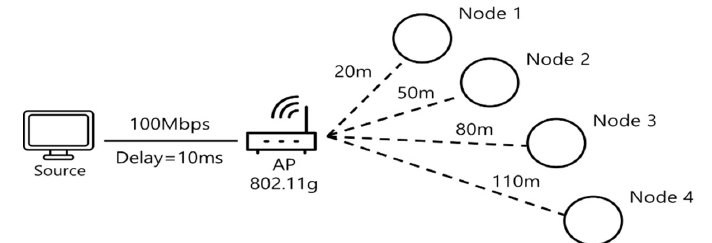
Figure 3. Code Segment of Responsible Airtime Fair Scheduling.